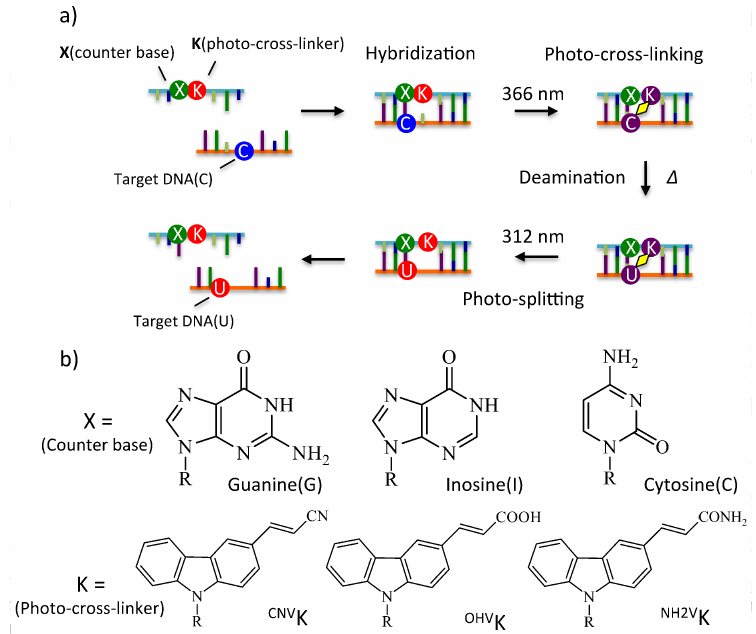
Figure 1. ( a ) Overview of photo-cross-link based cytosine deamination. ( b ) Chemical structures of counter bases and